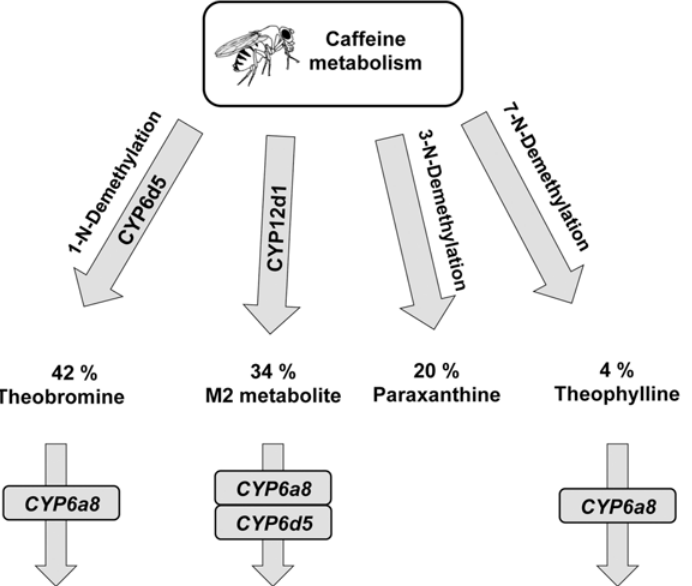
Fig 4. Hypothetic model for CYP6d5 , CYP6a8 and CYP12d1 involvement in caffeine metabolism pathway in Drosophila melanogaster . In male adult fly bodies, caffeine is degraded into 4 major metabolites: theobromine, M2, paraxanthine and theophylline. CYP6d5 and CYP12d1 seem to metabolize caffeine in theobromine and M2 metabolite, respectively. The metabolism of theobromine and theophylline into unknown secondary metabolites may be controlled by CYP6a8 whereas the M2 degradation could involve cooperation between CYP6a8 and CYP6d5 .